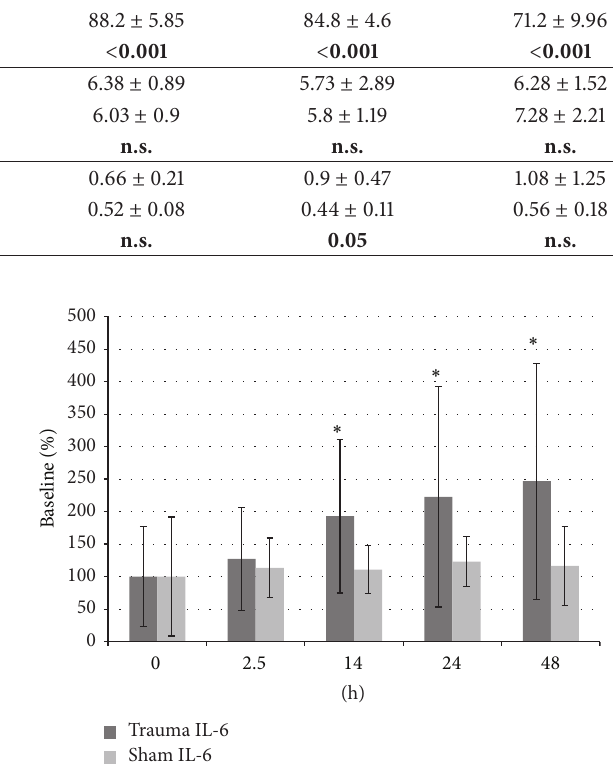
Figure 1: Serum IL-6 levels, ∗ = 𝑃 < 0.05 compared to sham group. concentrations ( 𝑃 = 0.028 ) and when compared to the sham group at the respective time point ( 𝑃 = 0.013 ) (Figure 3). After resuscitation, HMGB1 levels decreased with a sec- ondary peak at 24 h with significant differences compared to baseline values ( 𝑃 = 0.01 ) and compared to the sham group ( 𝑃 = 0.04 ). After trauma induction, HSP70 levels decreased (2.5 h: 𝑃 = 0.002 ; 14 h: 𝑃 = 0.021 ; 24 h: 𝑃 = 0.006 ) with significant reduced levels compared to the sham group at time points 2.5 h ( 𝑃 = 0.02 ) and 14 h ( 𝑃 = 0.026 ) (Figure 3).